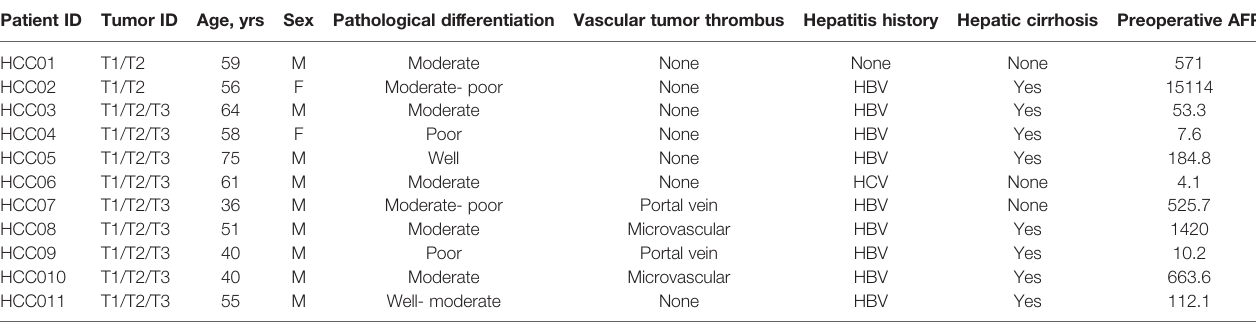
TABLE 1 | Summary of baseline clinicopathological characteristics of 31 tumoral focal from 11 HCC